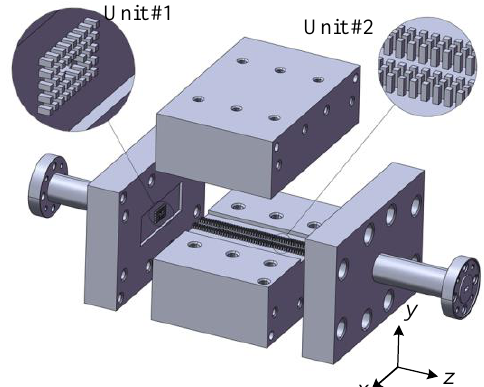
Figure 1. 3D view of the back-to-back transition. The left circle contains gap waveguide unit #1 while the right circle refers to gap waveguide unit #2.